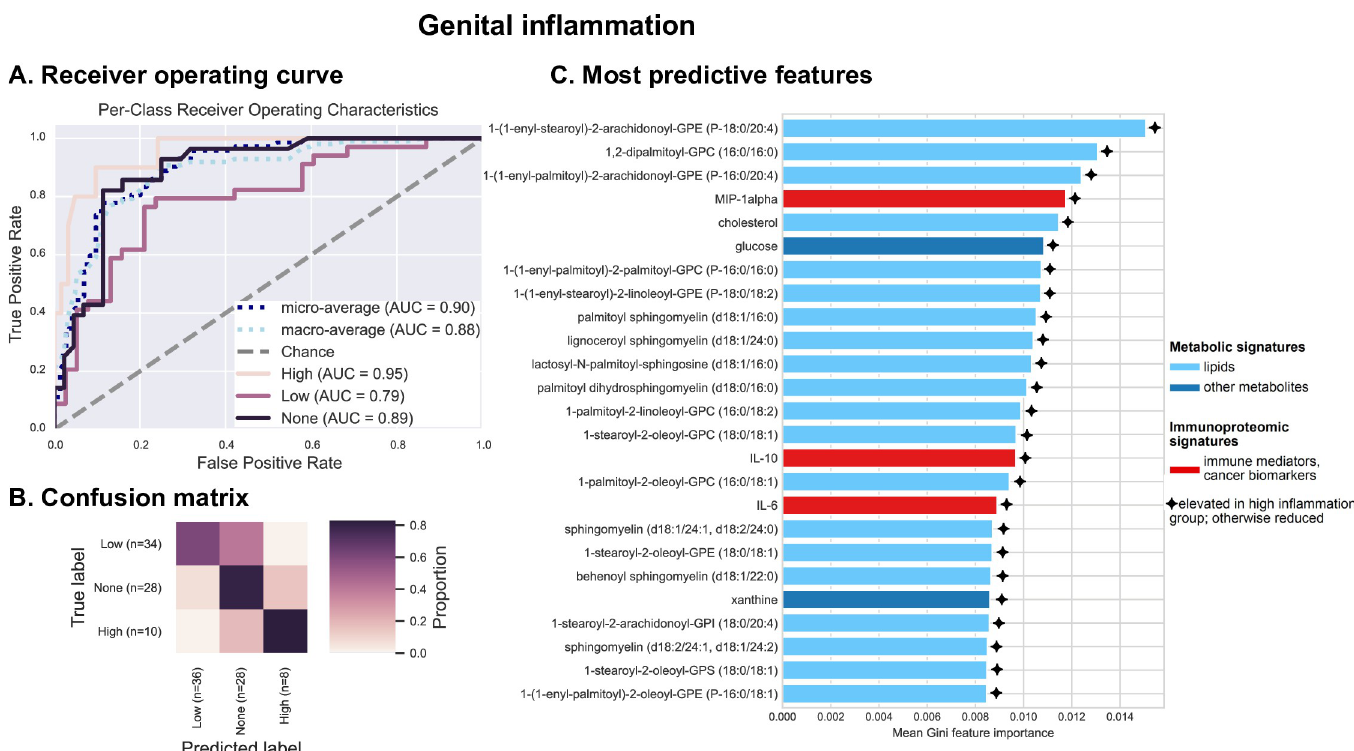
Fig 6. Various metabolites (particularly long-chain fatty acids, sphingolipids and glucose), protein biomarkers (IL-6, IL-10, MIP-1 α ) are the best predictors of the genital inflammation. Integrated vaginal microbiome, metabolome, and immunoproteome profiles (excluding the 7 cytokines used to score genital inflammation) were used as predictive features for training cross-validated Random Forest classifiers to predict whether a subject’s genital inflammation score was “no inflammation” (0), low (1–4), or high ( � 5.0). Combined measurements predict inflammation score at an overall accuracy rate of 77.8%. A 1.7-fold improvement over baseline accuracy was observed. Receiver operating characteristics (ROC) analysis showing true and false positive rates for each group, indicating moderate average accuracy (micro-average AUC = 0.90) and weak to good predictive accuracy for each group ( A ). The confusion matrix illustrates the proportion of times each sample receives the correct classification when evaluating the classifier at a threshold of 0.5 ( B ). The graphs depict the 25 most strongly predictive features ranked by their mean Gini importance score across all 10 trained classifiers, a measure of their overall contribution to classifier accuracy ( C ).